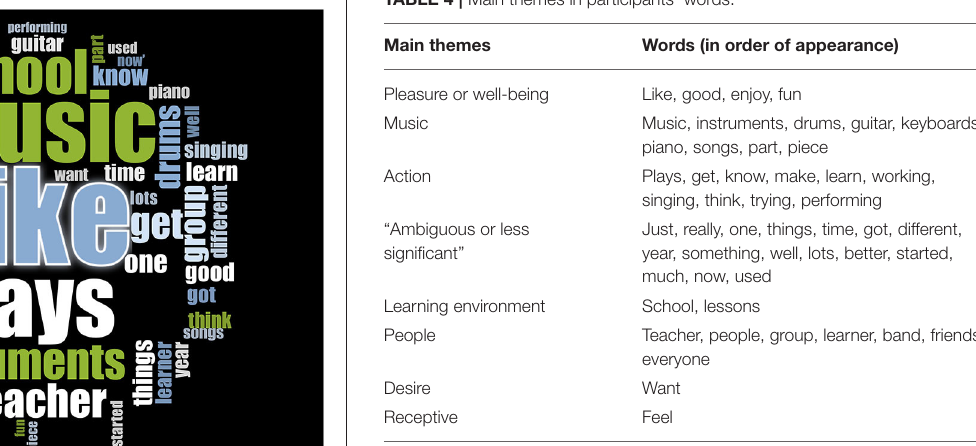
TABLE 4 | Main themes in participants’